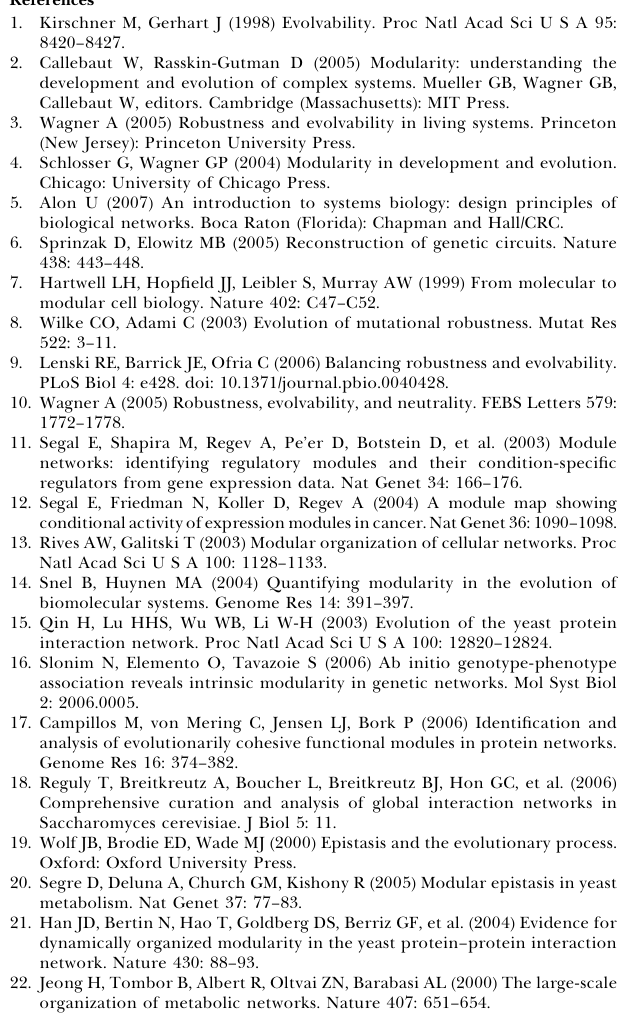
Figure S4. Robustness of Fitness under Precursor and Gene Removal Decrease of normalized log fitness with increasing precursor removal (A), node removal (B), as a function of the position on the line of descent (colors in inset of (A)). Depth 0: ancestor. Figure S5. Robustness of Decay of Knockdown Suppressor Pairs Fraction of knockdown suppressor pairs separated upon removing nodes with high BC using all (100%, weakest criterion) or fewer (only the top 10%–80%) of suppressor pairs. The top 95% of pairs were used for Figures 8A and S6. See legend for colors and thresholds. Found at doi:10.1371/journal.pcbi.0040023.sg005 (409 KB PDF). Figure S6. Modularity Analysis for Static and Quasi-static Environ- ments Analysis of the separation of pairs of genes from networks evolved in a static (A) and quasi-static (B) environment, as in Figure 8A. Red line, synthetic lethal pairs; green, dosage rescue pairs; black, random pairs; and grey, relative size of largest connected component. Found at doi:10.1371/journal.pcbi.0040023.sg006 (73 KB PDF). Figure S7. Distance Distribution of Pairs of Genes Distance distribution of pairs on a network evolved in static (A) and